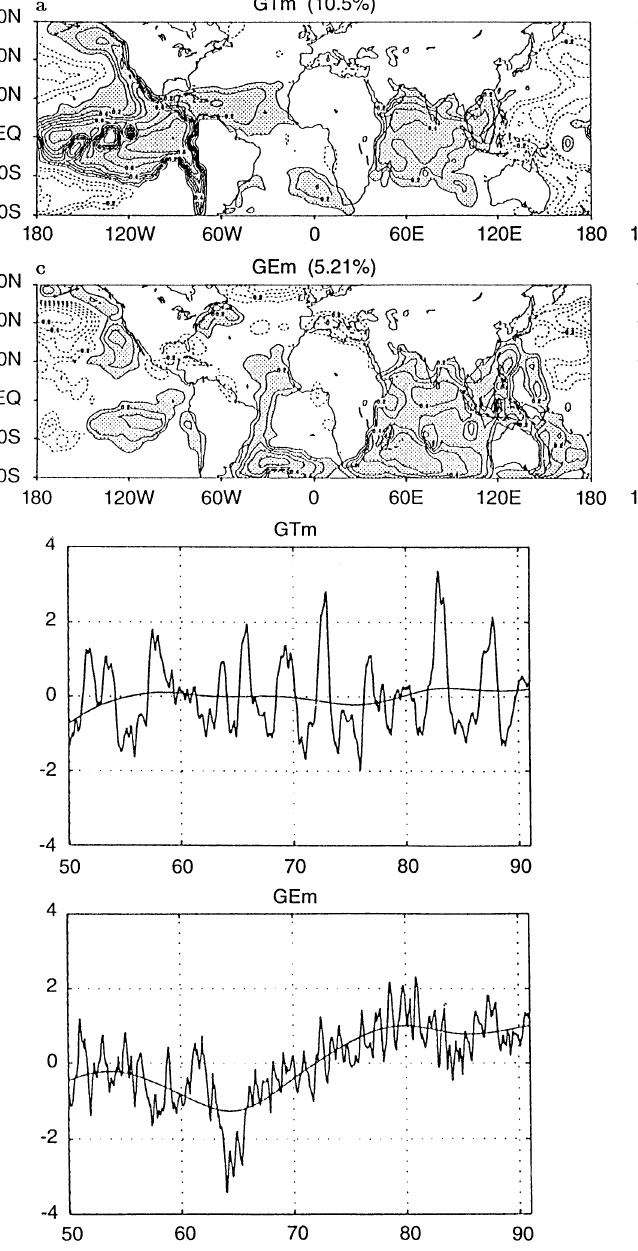
linear correlation coefficients every 0.1. Explained variance: a GTm (10.2%), b NAm (5.21%), c GEm (5.21%), d ESAm (5.03%). Rela- tive time-series with superimposed low-pass filtered curve (period ’ 7